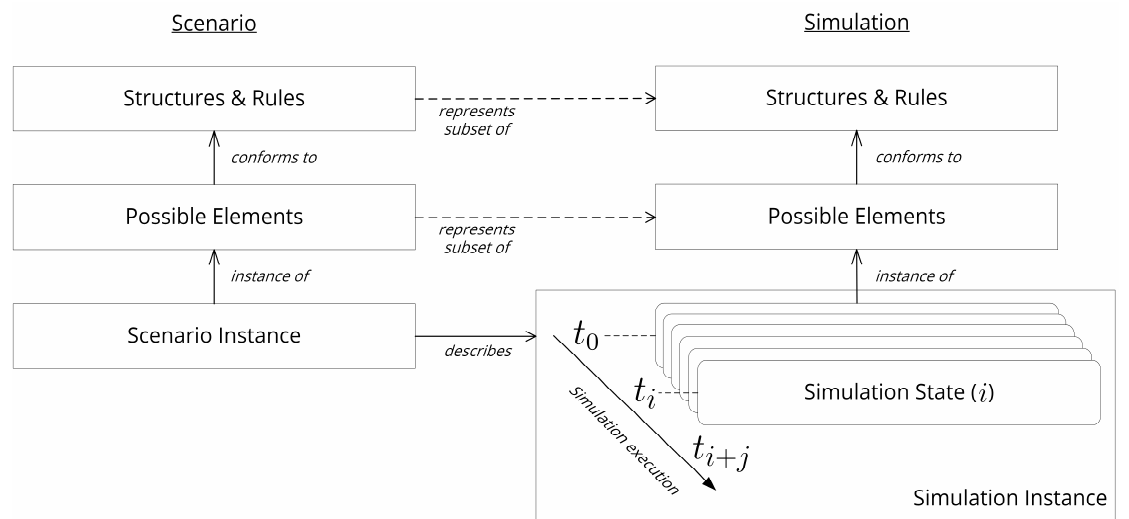
Figure 10. Structure and dependencies within and between the scenario being simulated and the simulation itself.